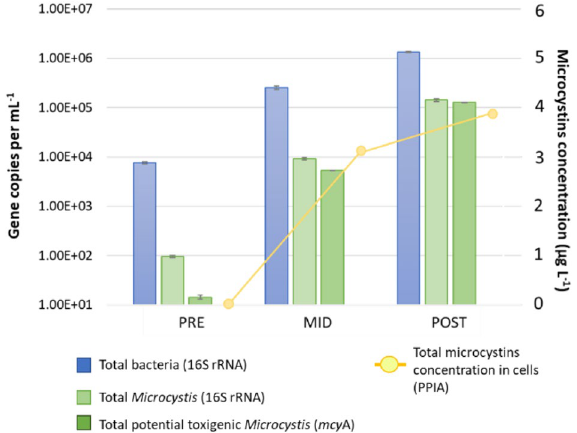
Figure 3. Dynamics of gene abundance and microcytins toxicity (µg L −1 ) in particle-attached bacteria sample fractions (PAB). PRE pre-summer period, MID mid-summer period, POST post-summer